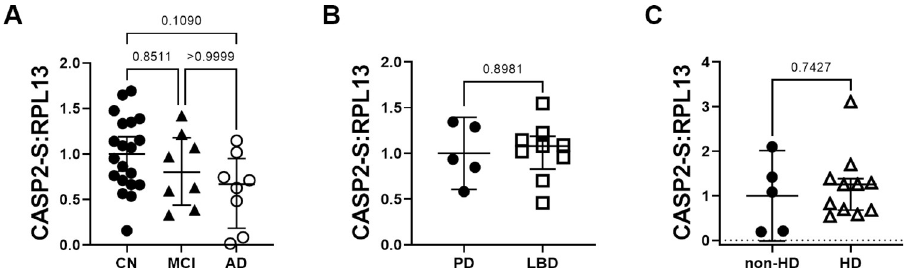
Fig 4. Caspase-2S relative mRNA expression levels in neurological disease. (A) Caspase-2S mRNA expression levels trend lower in AD but not MCI compared to CN controls. Caspase-2S mRNA do not differ in LBD (B) or HD (C) compared to controls.